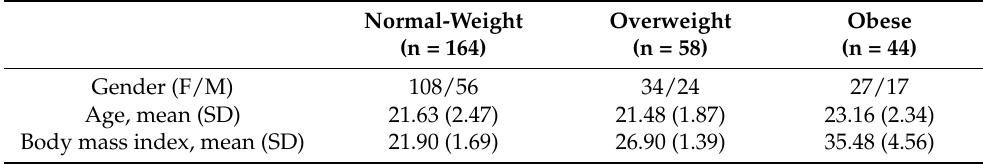
Table 1. Anthropometric sample